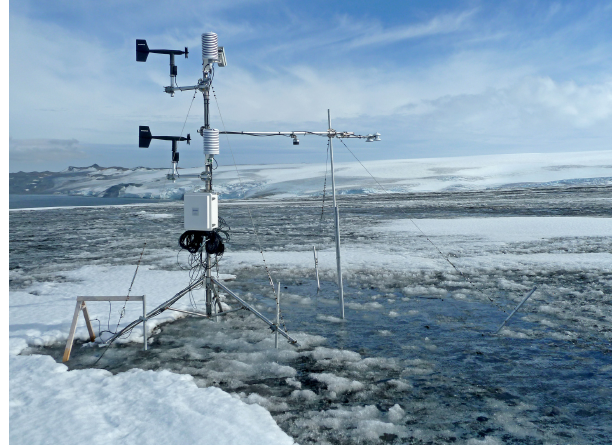
Figure 3. AWS installed on the Fourcade Glacier with view to the Potter Cove and Three Brothers Hill. The photo was taken on 4 March 2012 and shows the AWS during the ablation period when pyroclastic material resurface due to melting of the winter snow